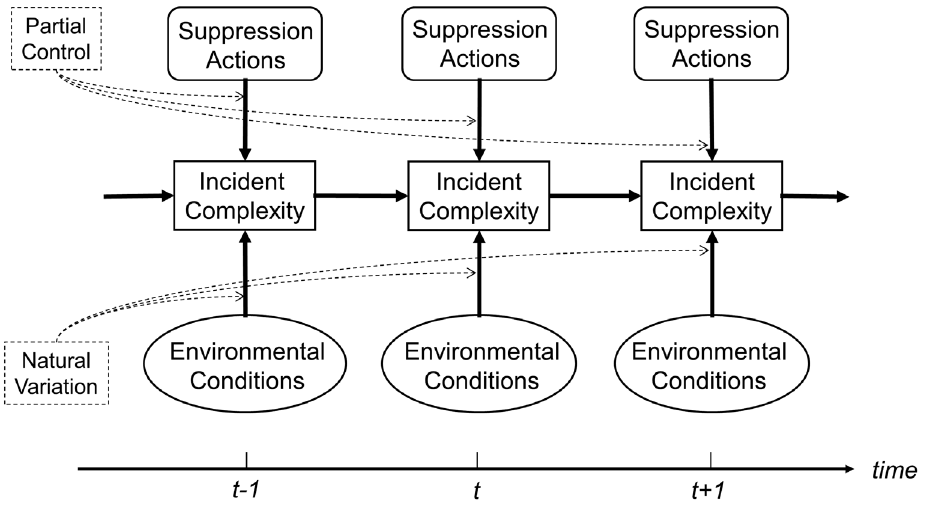
Figure 1. Model of the evolution of wildfire incident complexity dynamics through time. At each time step (day), suppression actions and environmental conditions jointly influence the complexity of the incident. Stochasticity in system evolution is due to partial control and natural variation. System evolution begins with incident detection and ends with containment. Adapted from [12].